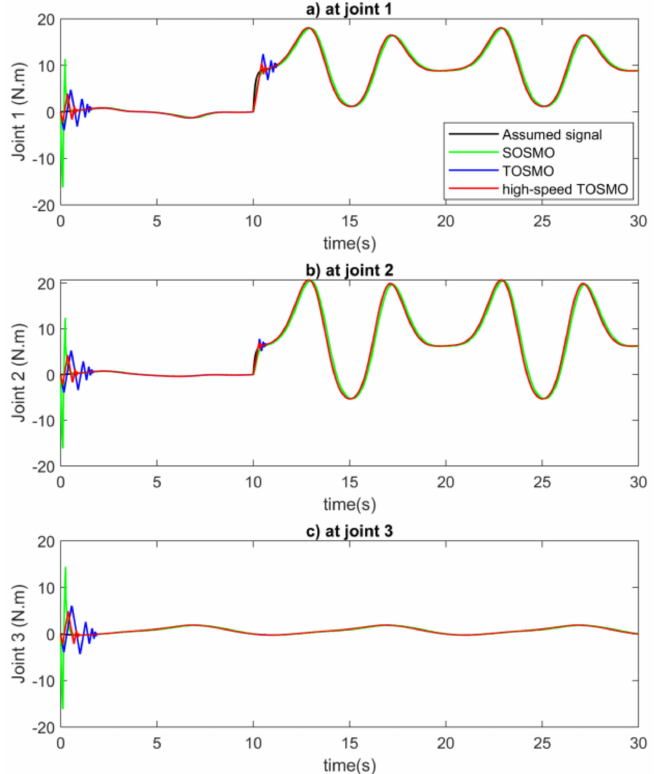
Figure 4. Lumped unknown input estimation at ( a ) joint 1, ( b ) joint 2 and ( c ) joint 3.